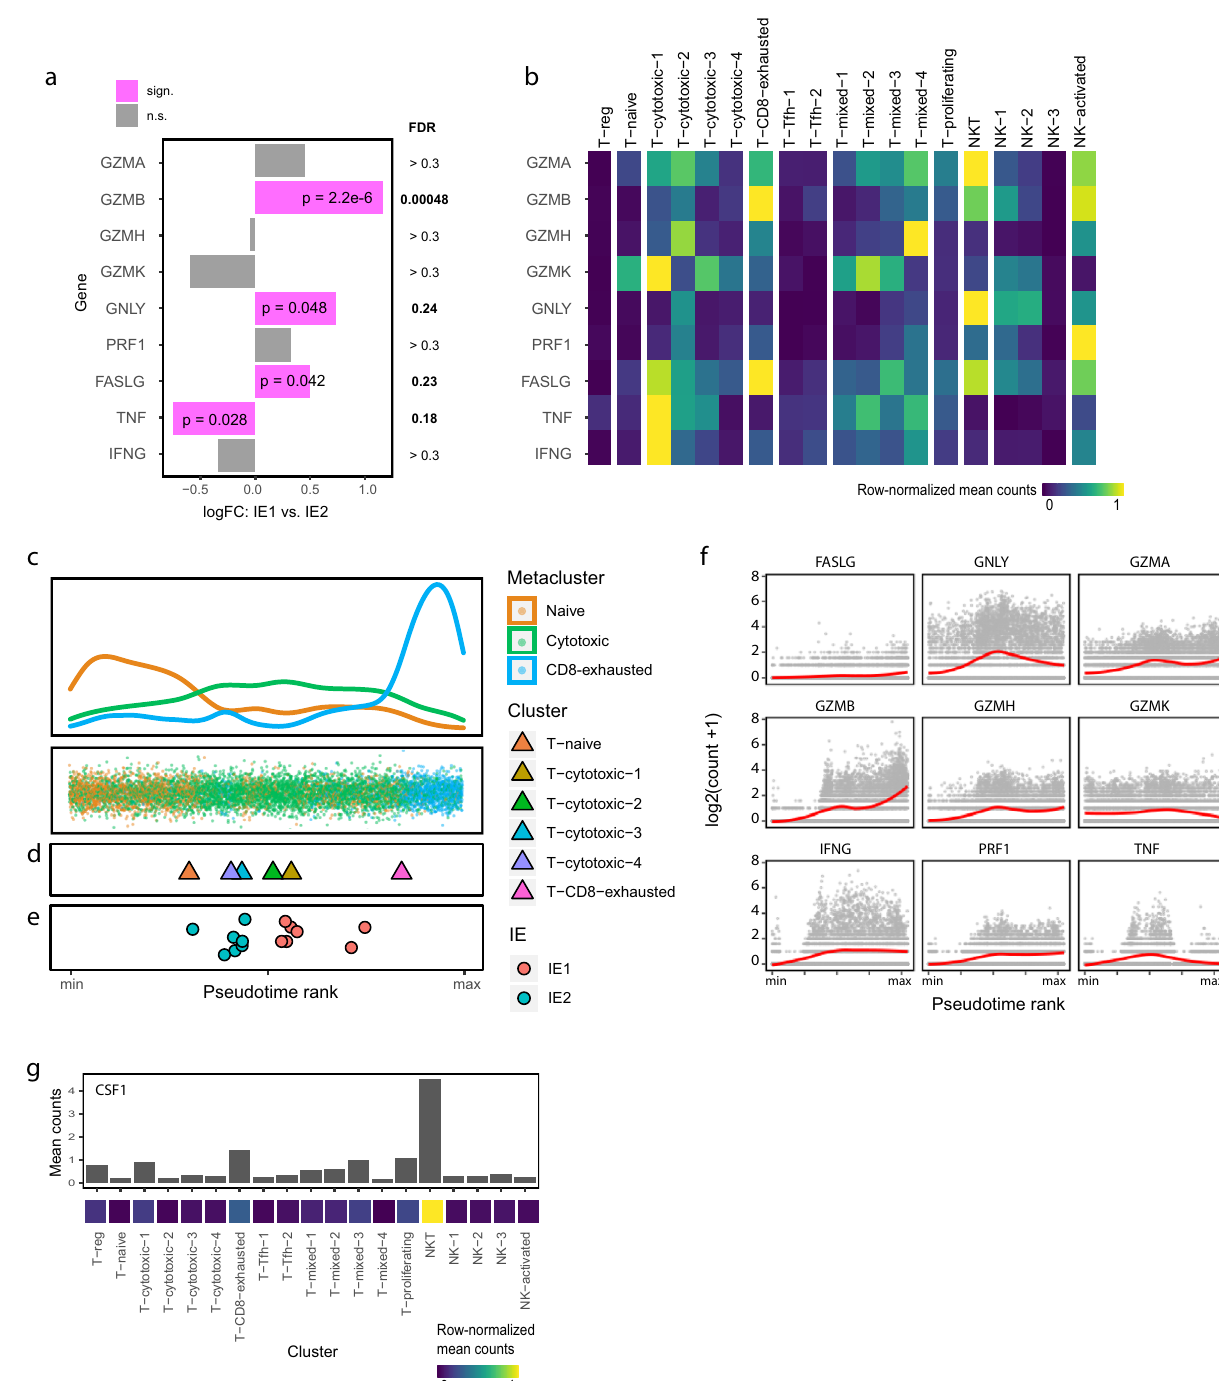
Fig.3|Cytotoxiceffectorpro fi lesdifferbetweenexhaustedandnon-exhausted immuneenvironments.a Barplotshowingdifferentialexpressionoftheindicated transcripts in T and NK cells between IE1 and IE2 tumors (patient-averaged